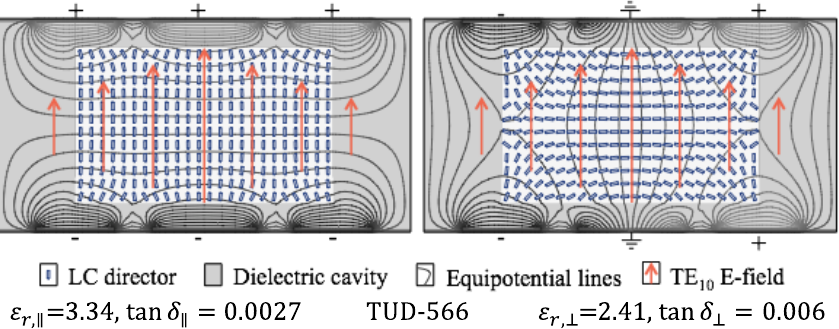
Figure 15. Schematic of the director distribution in a partially LC-filled waveguide phase shifter for both extreme tuning states parallel ( left ) and perpendicular ( right ) to the RF field 𝐸(cid:4652)⃗ (cid:3019)(cid:3007) , using a configuration of three electrode pairs. The values below are given for the LC TUD-566. Reprinted from [2], Cambridge University Press, 2020.